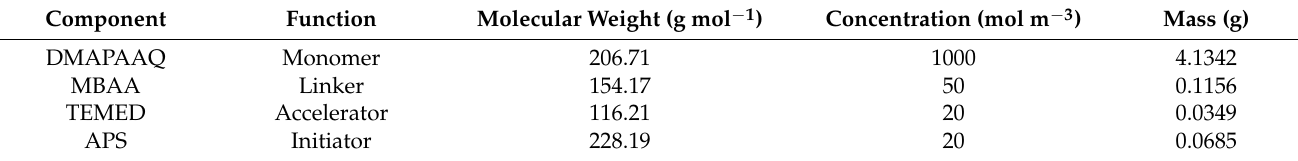
Table 8. Synthetic condition of DMAPAAQ